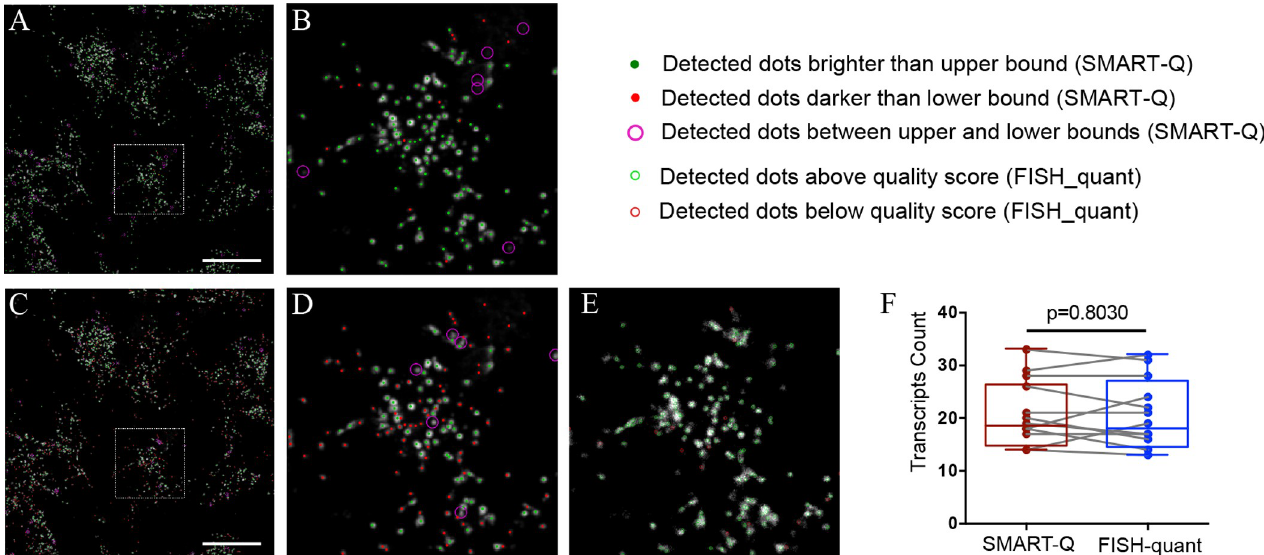
Fig 2. Assessing the quality of RNA detection results. Graphic representations of the intensities of all detected spots relative to a chosen upper bound intensity and lower bound intensity. By comparing the results of different bounds, the user can determine an optimal minimum brightness for detecting gene transcripts. (A, B) Upper bound intensity of 0.07 and lower bound of 0.06. (C, D) Upper bound of 0.24 and lower bound of 0.23. B and D are the zoom-in of boxed subregion in A and C. The scale bar in A and C are 50 μ m. (E) RNA detection by FISH-quant with the same data source in B or D. Detected dots with min_intensity = 200, quality score > 60 (green circles). (F) Paired RNA detection are performed among 5 coverslips using SMART-Q or RNAscope. Paired t test. N = 12, P = 0.8030.